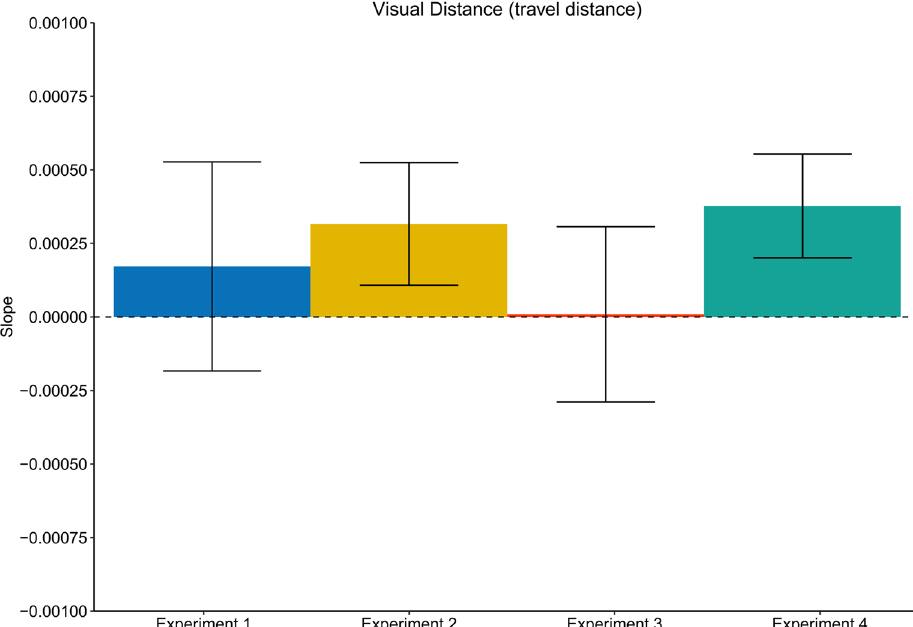
Figure 9. Average slopes representing the judged to distance ratio of visual judgement trials as a function of the travel distance in trial n W − 1 for all experiments. Error bars represent the SEM. Experiment 1: physical walking with optic flow; Experiment 2: artificial walking with optic flow; Experiment 3: physical walking without optic flow; Experiment 4: physical walking with optic flow until prompted to